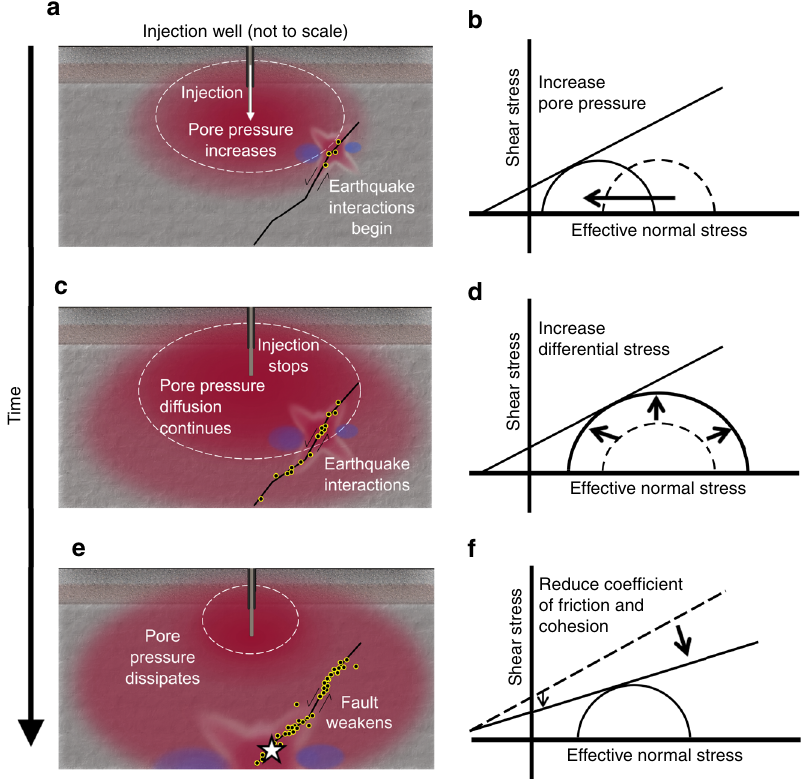
Fig. 7 Conceptual illustrations of causal mechanism. Red areas represent pore pressure increase from fl uid injection. Superimposed on the pore pressure cloud is the Coulomb static stress. The black line is a fault with sense of slip shown with arrows and earthquakes are indicated by small dots outlined in yellow. Dashed white contour is a pore pressure contour of constant magnitude. Elapsed time since start of injection increases from fi rst to third row. a Pore pressure increase after a period of constant injection with the start of induced seismicity. b Mohr – Coulomb diagram showing triggering due to increased pore pressure along a preexisting critically stressed fault. c Pore pressure increase continues to expand following cessation of injection and more earthquakes are induced. d Mohr – Coulomb diagram showing triggering due to increase of differential stress along the fault. e High pore pressure increase starts to dissipate, but moderate pore pressure increase continues to diffuse away from well, and earthquakes continue and a larger event occurs (white star). f Mohr – Coulomb diagram showing triggering caused by weakening of the fault due to reduction of the coef fi cient of friction and reduced cohesion 42